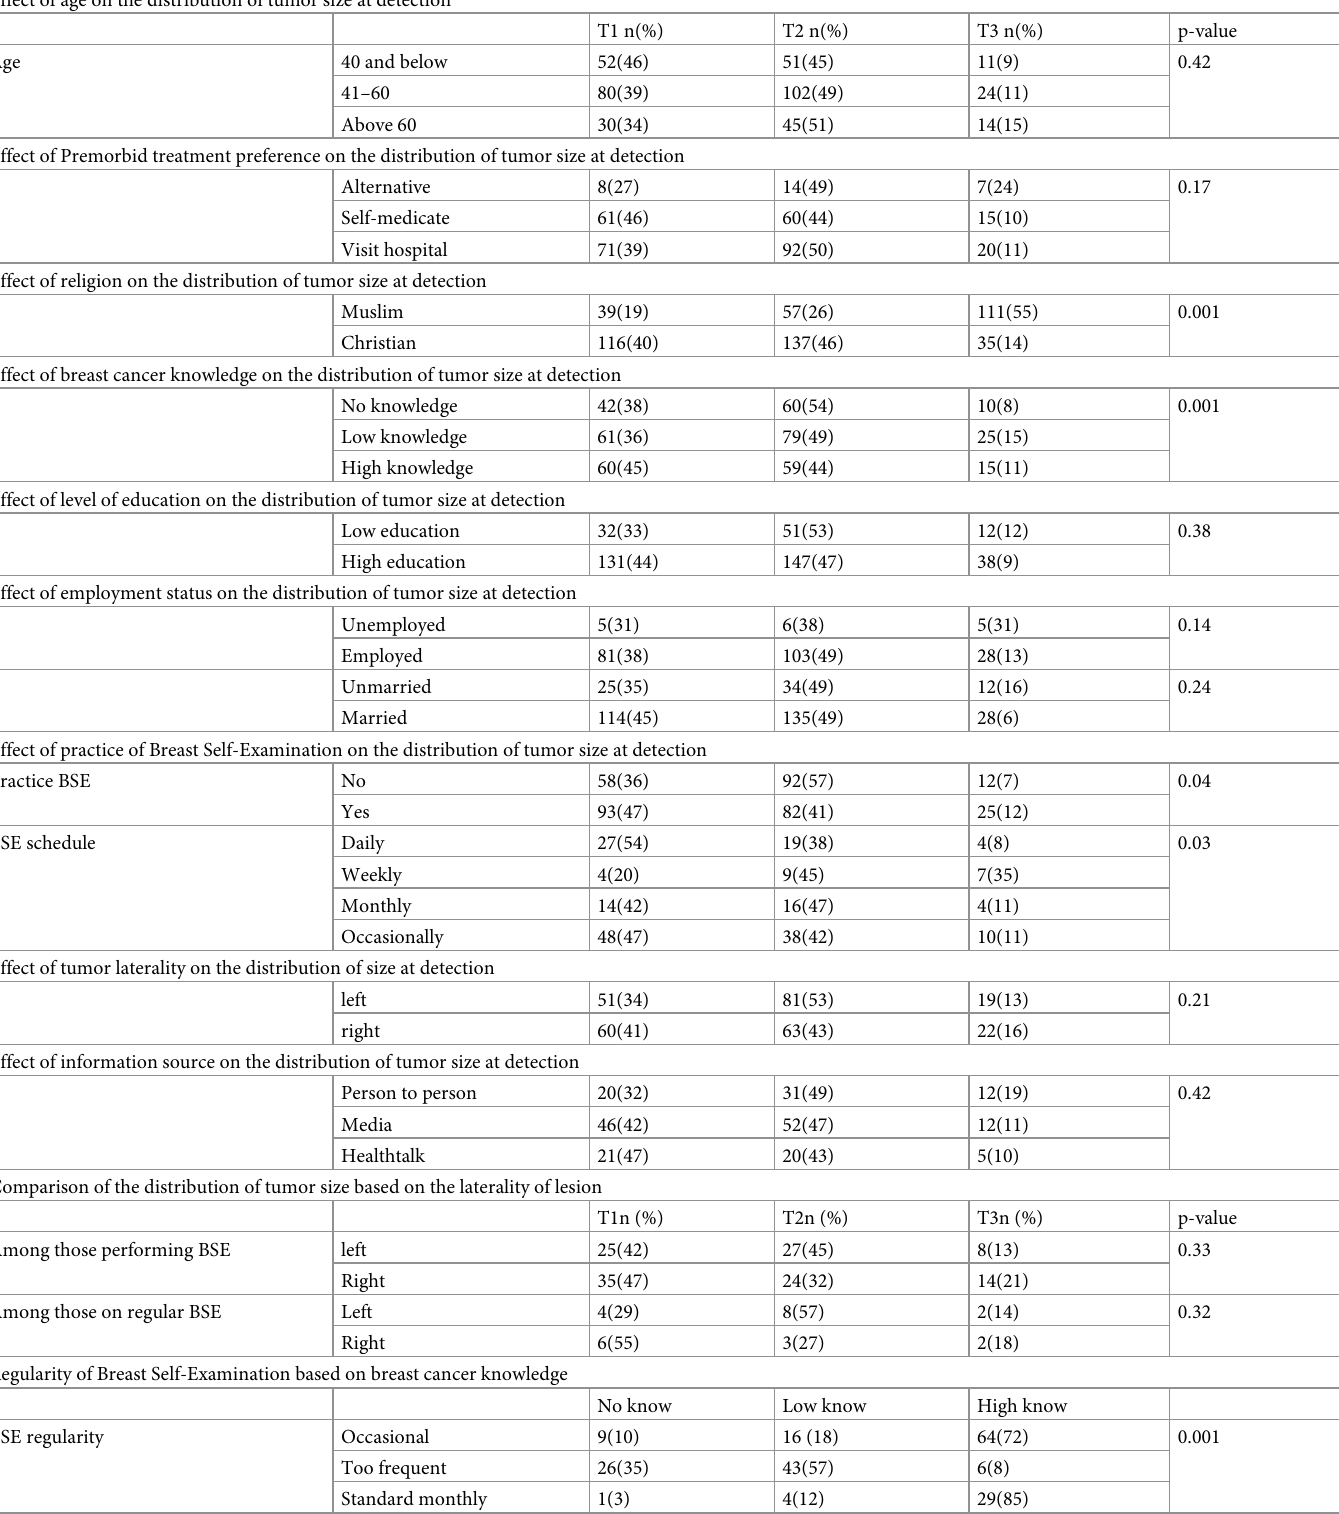
Table 2. The effect of the demographics, premorbid treatment preferences, level of knowledge, and practice of breast-self examination on tumor size distribution at detection. Also, showing the regularity of Breast Self-Examination based on breast cancer knowledge. Effect of age on the distribution of tumor size at